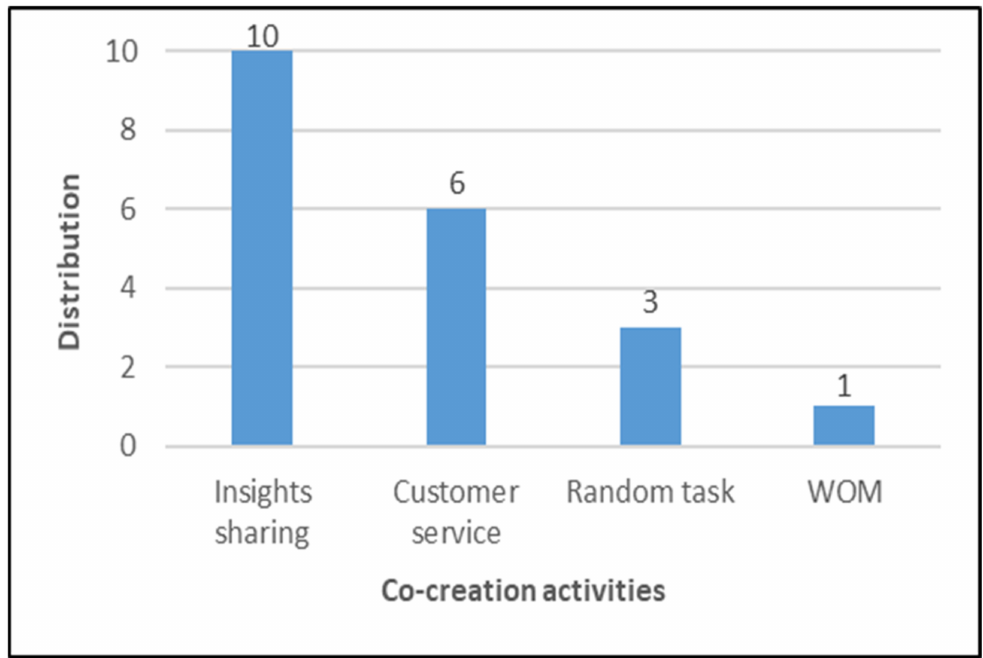
Figure 3. Distribution of co-creation activities across “crowdsourcing” case studies.